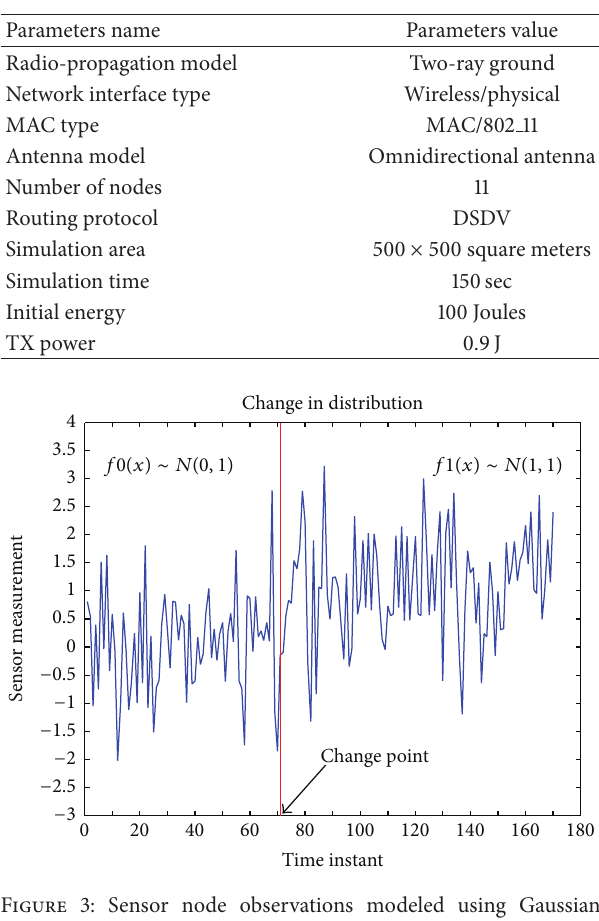
Figure 3: Sensor node observations modeled using Gaussian